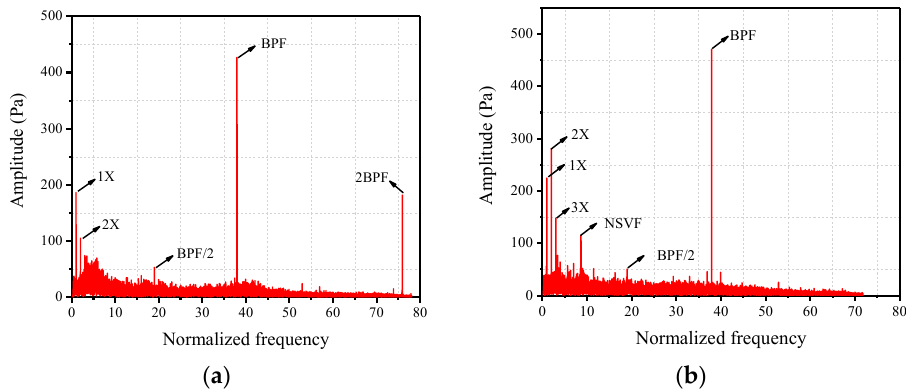
Figure 17. Frequency domain comparison of stable state and non-synchronous vibration (NSV) state (PVDF-01): ( a ) stable state ( b ) NSV state.